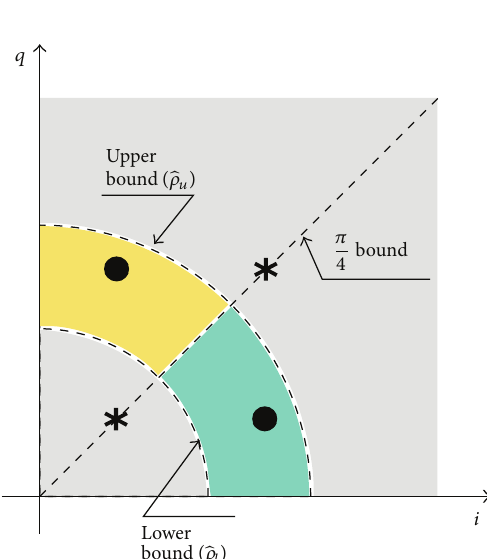
Figure 9: QPSK and 16-QAM square constellation.